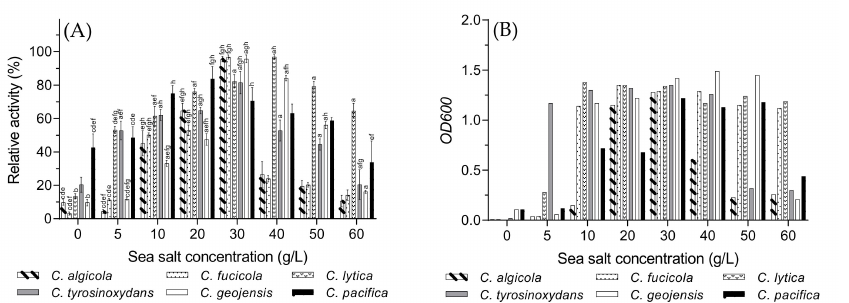
Figure 4. The effects of different sea salt concentrations on Cellulophaga species on ( A ) ι -carrageenase production and ( B ) cell growth presented as optical density ( OD 600 ). Values of Figure 4A are expressed as mean ± SEM (n = 4). Data comparison was performed against sea salt concentrations. a = when compared with 0 g/L, b = when compared with 5 g/L, c = when compared with 10 g/L, d = when compared with 20 g/L, e = when compared with 30 g/L, f = when compared with 40 g/L, g = when compared with 50 g/L, h = when compared with 60 g/L. Different lowercase letters on the bars indicate statistically significant differences from respective group using ANOVA, followed by Tukey’s comparison test ( p <